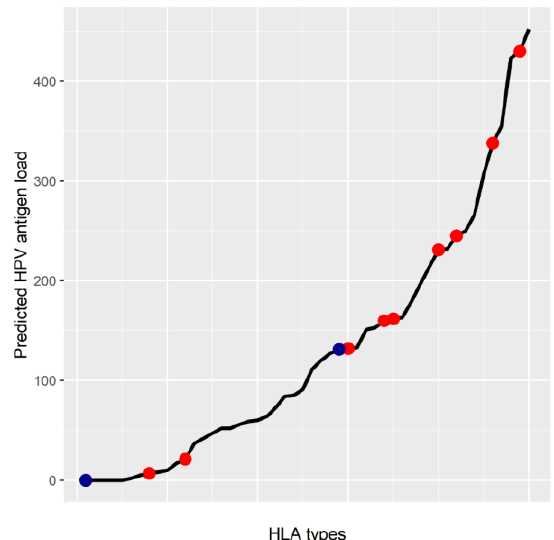
Figure 1. The predicted HPV antigen load of all common MHC class I haplotypes. All possible antigens were generated from the canonical peptide sequences encoded from HPV16, and each antigen’s binding a ffi nity to each HLA haplotype was predicted using NetMHC 4.0 [28]. Predicted HPV antigen load is the sum of all HPV antigens predicted to strongly bind to each MHC class I protein (binding a ffi nity < 500 nM). All MHC haplotype available from the immune epitope database are included in this analysis [53]. Specific HLA alleles are highlighted. Red points correspond to HLA alleles associated with increased risk of cervical cancer, and blue points are protective alleles for cervical cancer